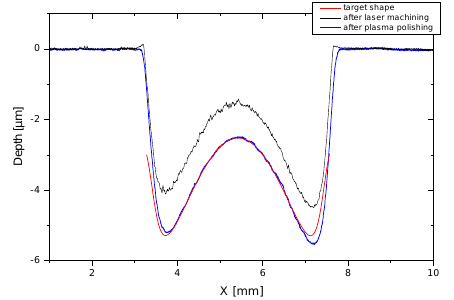
Fig. 4. Cross section profiles of targeted shape (red), after laser machining (black) and after plasma polishing